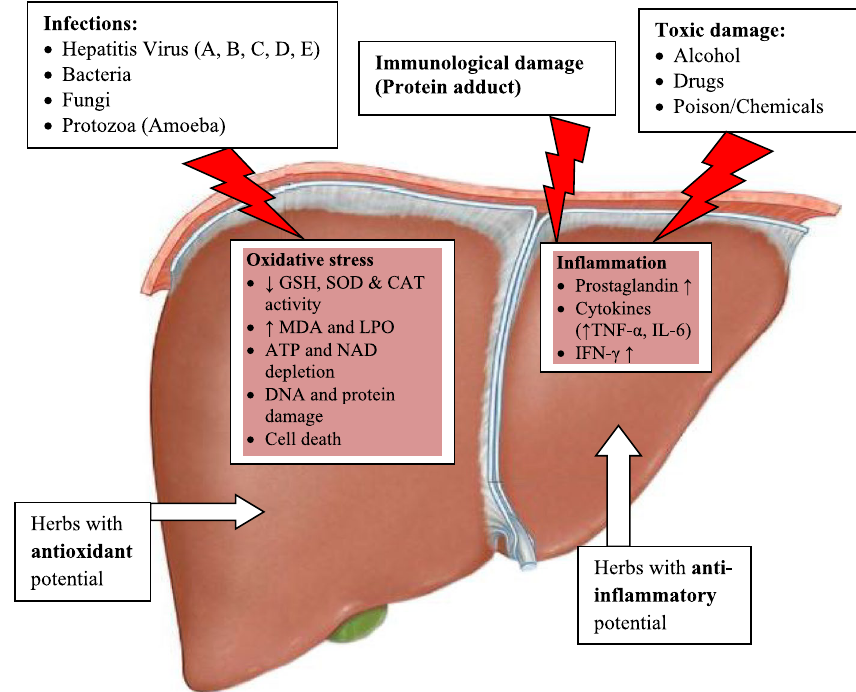
Fig. 2 The mechanism by which herbal remedies protect against liver injury from different toxins and injurious stimuli